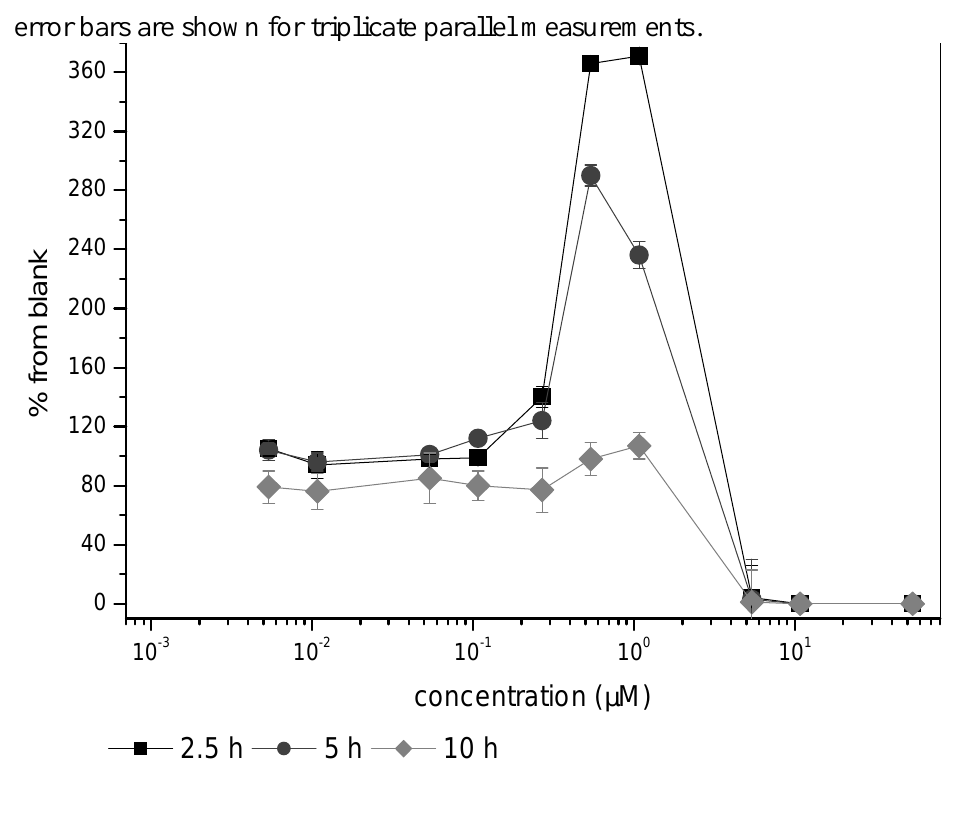
Figure 2. The bioluminescence response to nystatin, exposure of 2.5, 5 and 10 h. Squares (2.5 h), circles (5 h) and diamonds (10 h) denote for exposure used, respectively. The error bars are shown for triplicate parallel